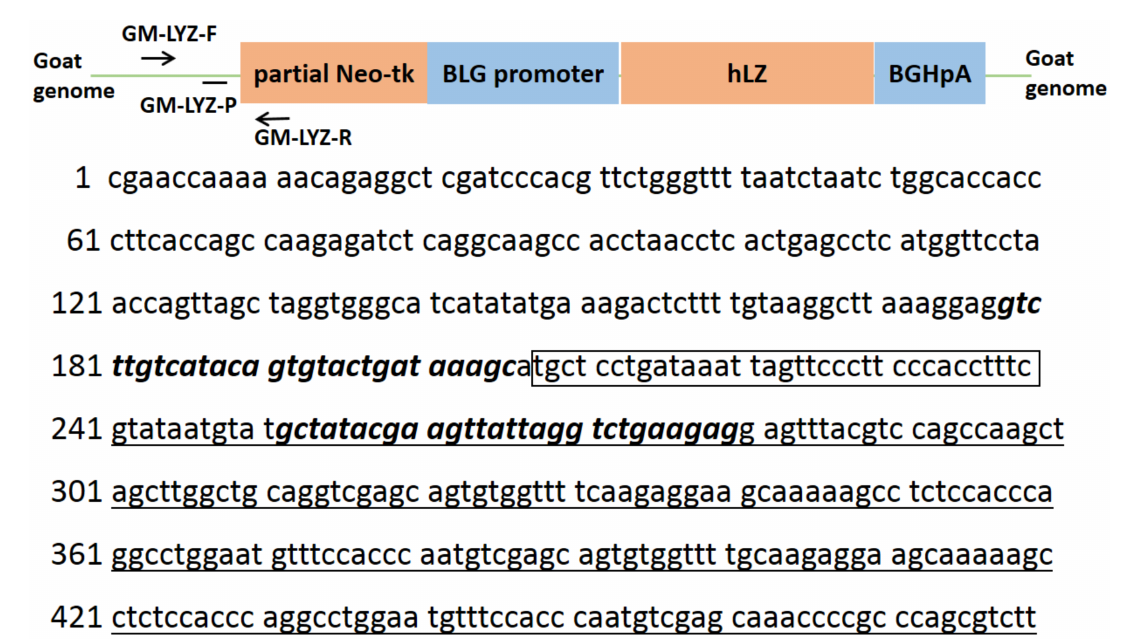
Figure 1. Sequence information and the location of the event-specific primer/probe set for transgenic human lysozyme (hLZ) goat lines. Partial Neo-tk, partial sequence of the neomycin resistance cassette; BLG promoter, bovine β -lactoglobulin promoter; hLZ, human lysozyme gene; BGHpA, bovine growth factor polyadenylation fragment. Lowercase letters not underlined indicate the goat genomic DNA sequence. Lowercase letters underlined indicate exogenous DNA from the partial Neo-tk cassette. Letters in bold italics indicate the designed forward and reverse primers. Letters in the frame indicate the designed TaqMan